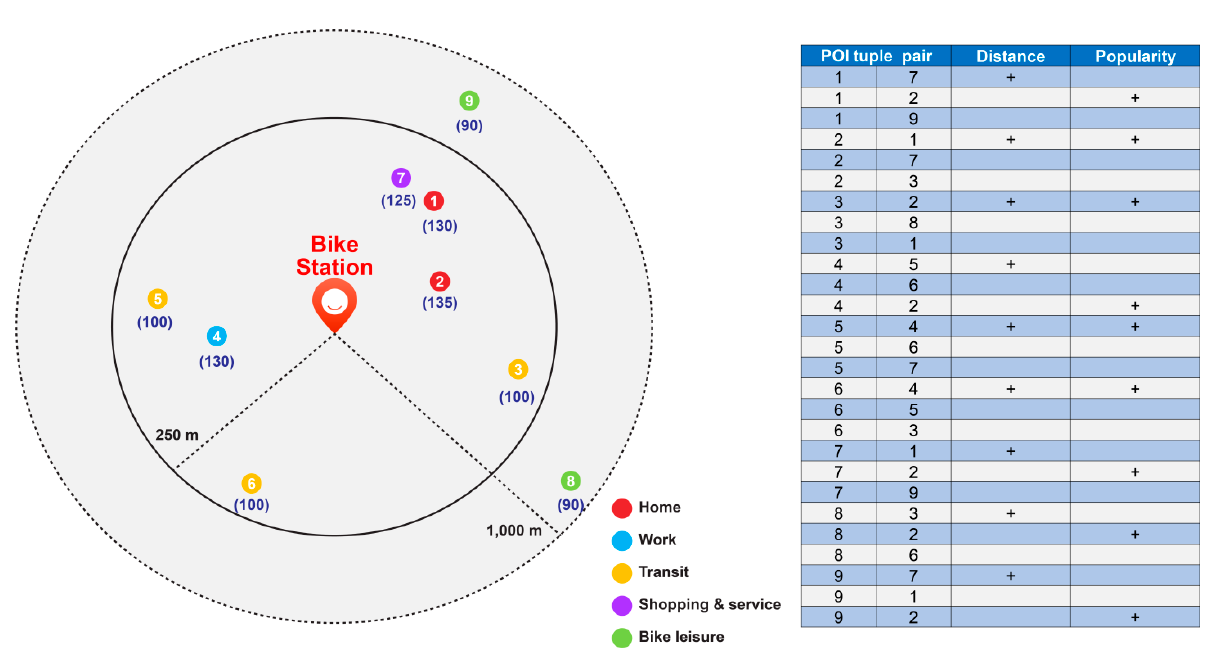
Figure 3. Composition of a POI tuple pair at a bike station.